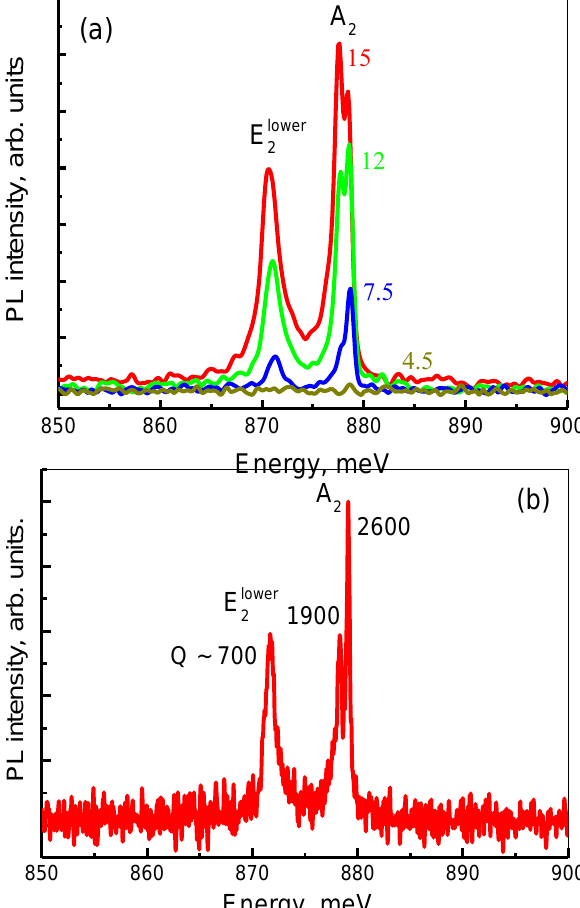
Figure 7. ( a ) The DPL spectra of PCS with a = 650 nm measured in the spectral range of PL lines associated with E 2 and A 2 modes. The spectra were measured within various collection angles with the spectral resolution of 4 cm − 1 . The signal collection angles (2 Θ ) are indicated next to the corresponding spectrum. ( b )—DPL spectrum of PCS with a = 650 nm measured within collection 2 Θ ~ 6 ◦ with the spectral resolution of 0.5 cm − 1 . The Q factors values are indicated next to the observed PL lines.